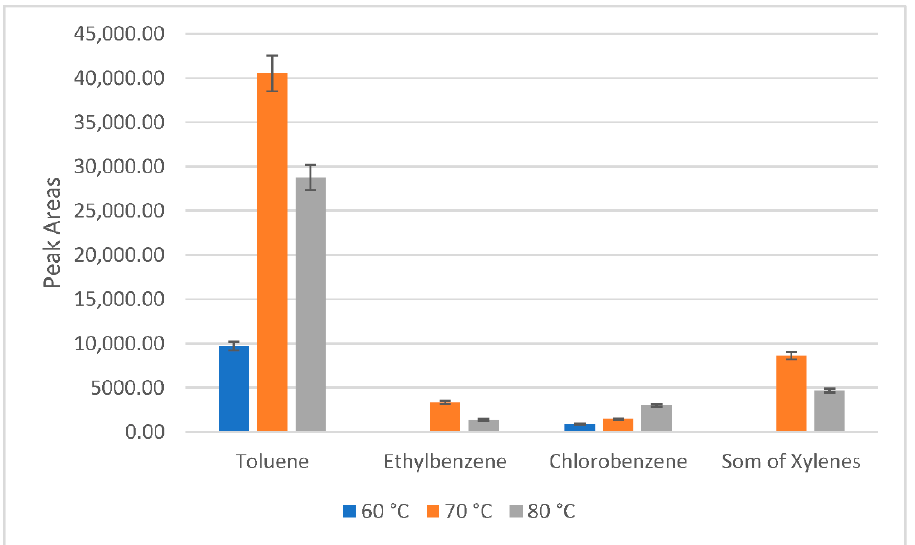
Figure 1. The effect of the headspace sampling temperature on the efficiency of the sampling of toluene, ethylbenzene, chlorobenzene, and total xylene transfer to the gas phase. The dependence of the peak areas on the sampling